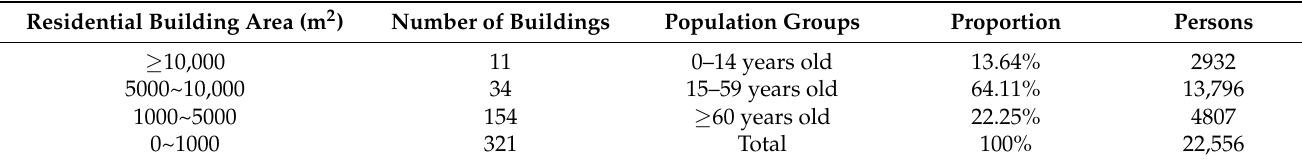
Figure 3. 3D model of the studied community. Table 2. Residential buildings and population distribution in the